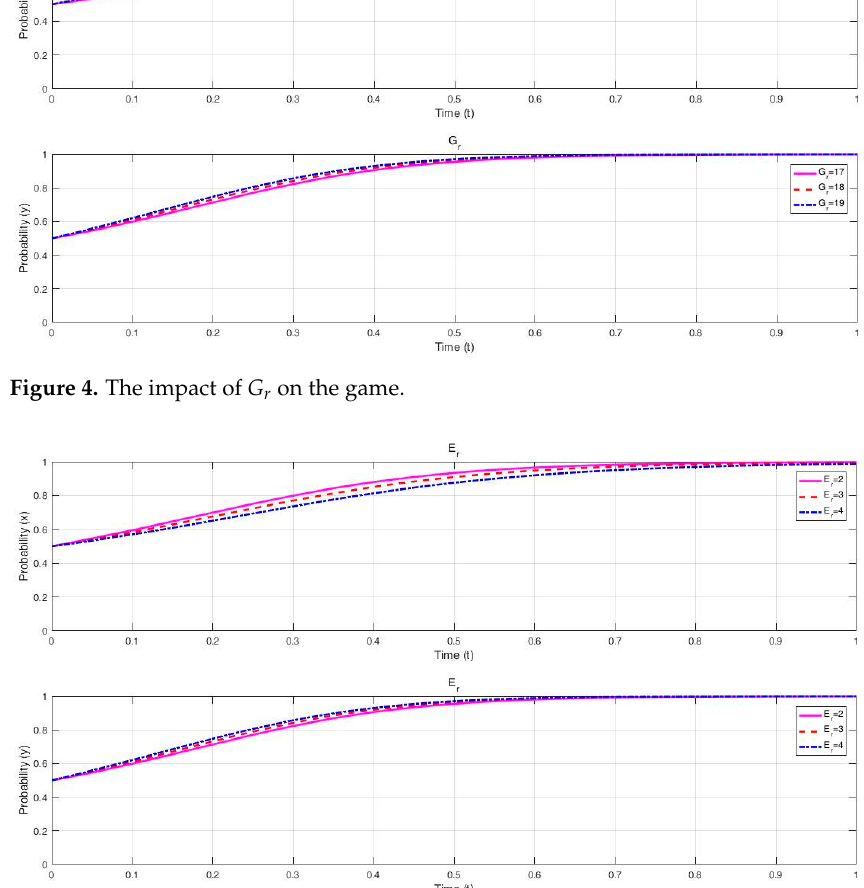
Figure 6. The impact of S g on the game.